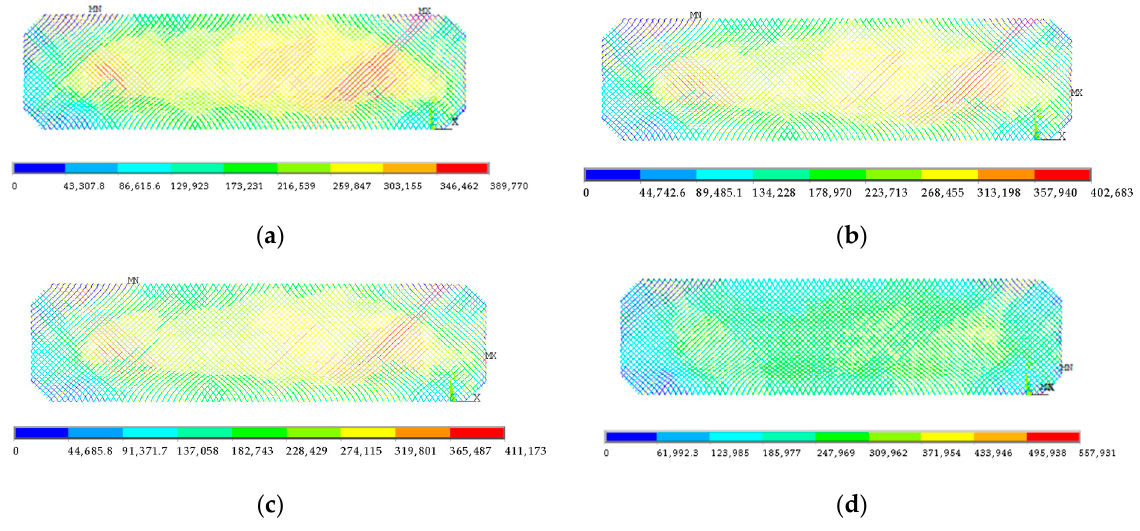
Figure 12. Cloud chart of cable net axial force (unit: N): ( a ) μ = 0.2; ( b ) μ = 0.44; ( c ) μ = 0.68; and ( d ) μ = ∞ *.